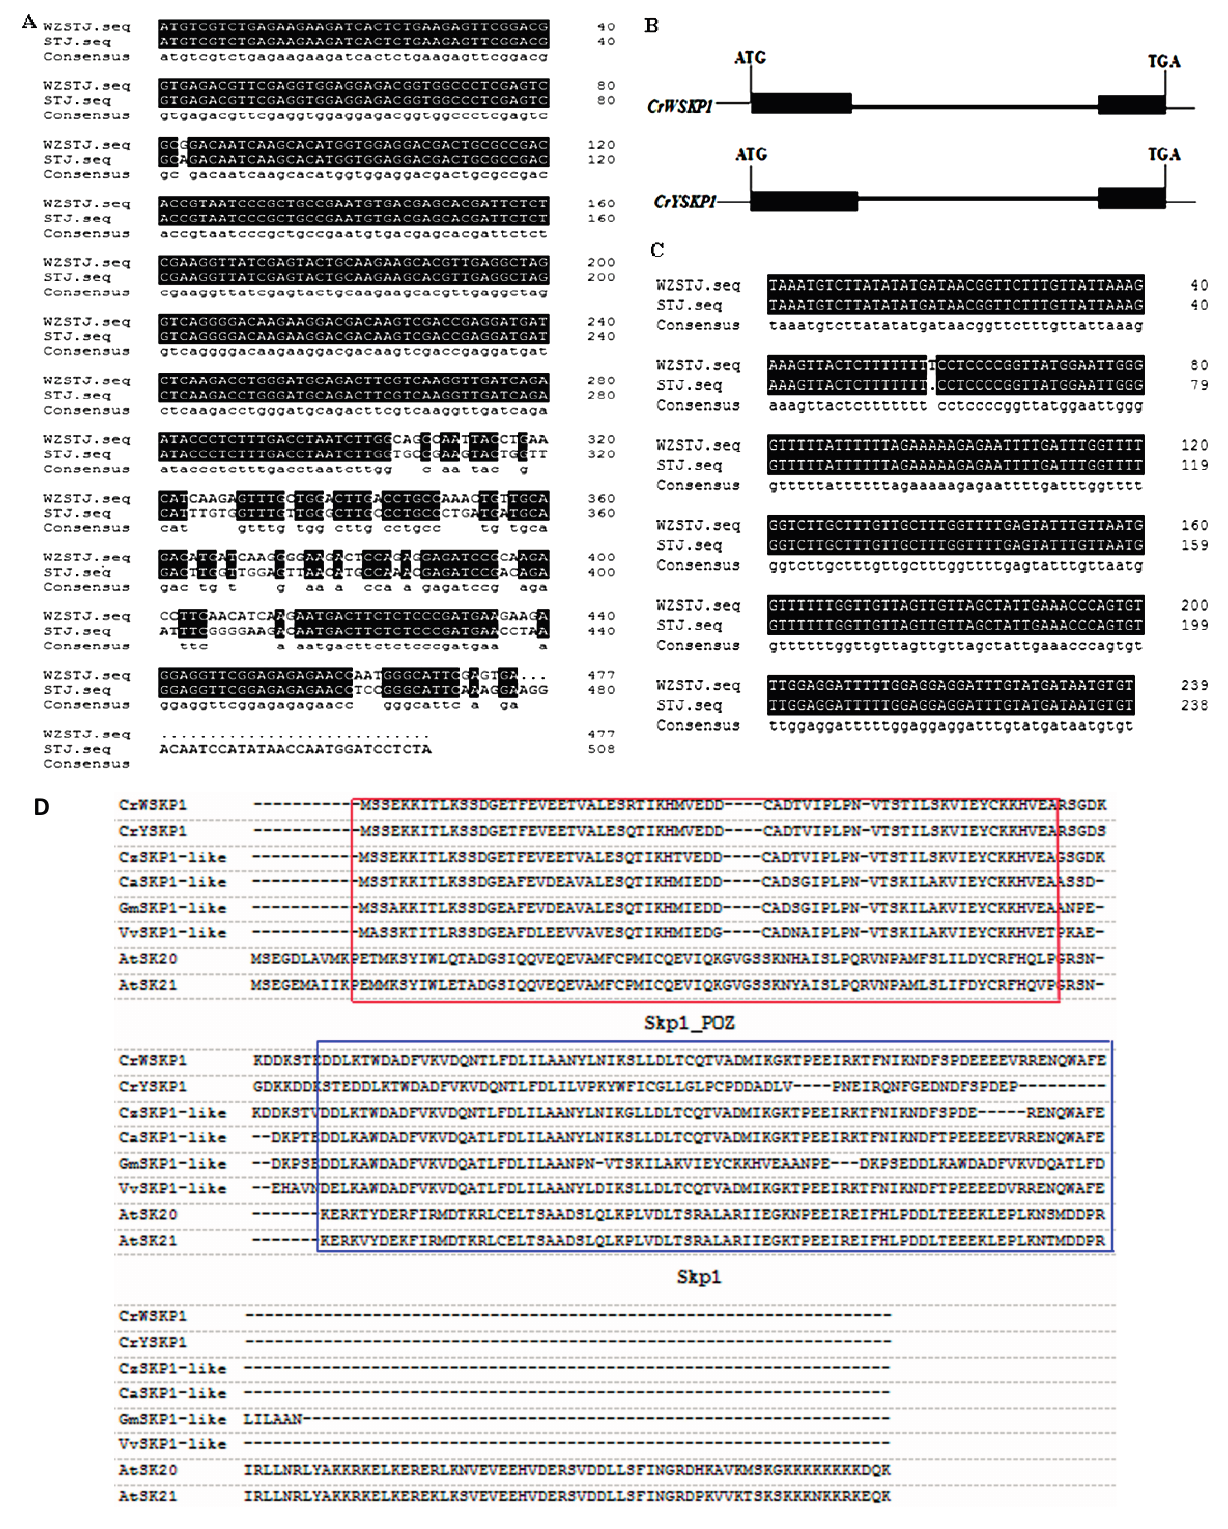
Figure 1. Analyses of CrWSKP1 and CrYSKP1 genes. ( A ) Alignments of cDNA sequences of CrWSKP1 and CrYSKP1 genes between “Wuzishatangju” (WZSTJ) and “Shatangju” (STJ); ( B ) Exon-introns structure of CrWSKP1 and CrYSKP1 genes. CrWSKP1 , DNA sequence of the Skp1-like gene from “Wuzishatangju”; CrYSKP1 , DNA sequence of the Skp1-like gene from “Shatangju”. Solid boxes indicate exons, and bold lines